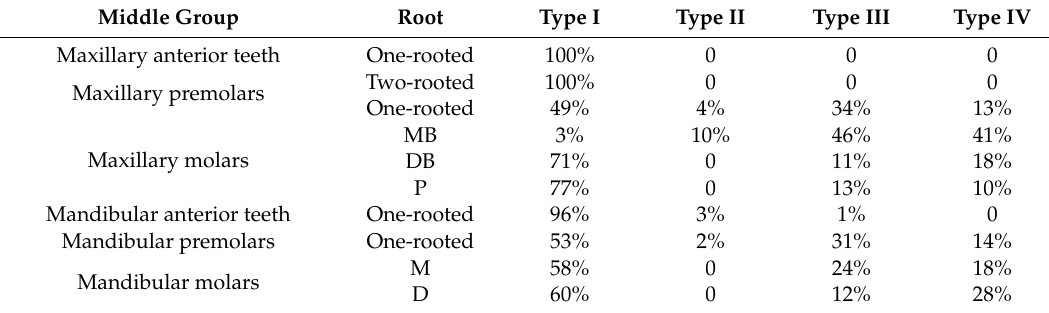
Table 4. Changes of cross-sectional root canal shape in middle age group.